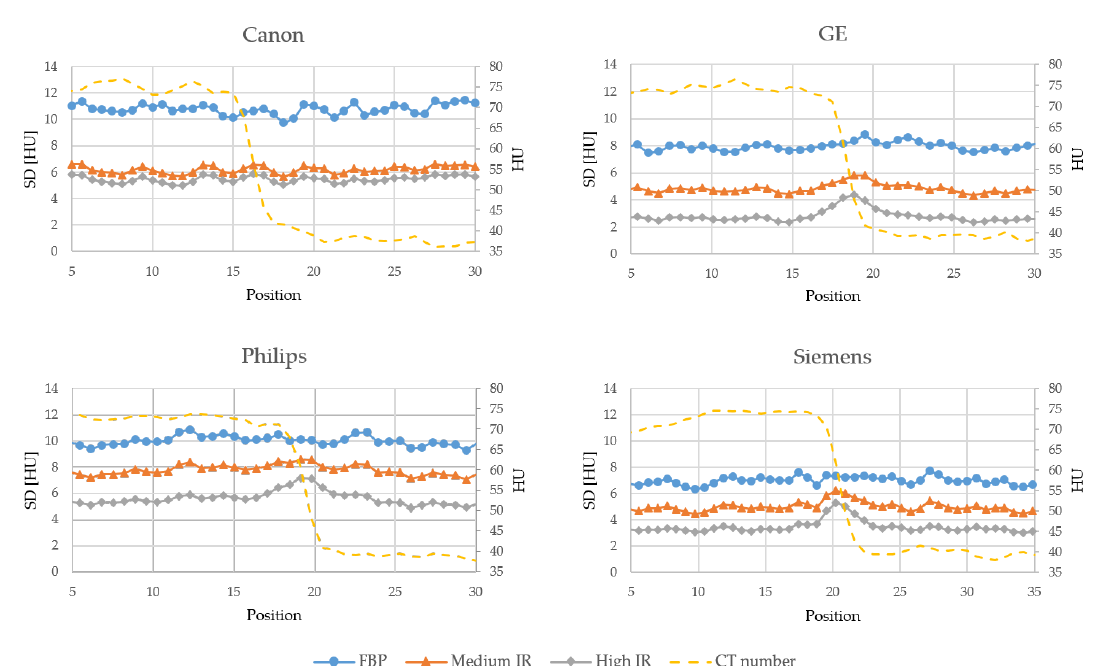
Figure 5. Edge profiles showing the standard deviation (SD) measured over the 30 HU edge in the noise maps reconstructed with FBP, a medium level of IR and a high level of IR for each vendor. The dashed line shows the average CT number in the FBP images. Table 2. Average amount and standard deviation of noise reduced outside and at three anatomical edges for two levels of IR relative to FBP, measured in the calculated noise maps (see Appendix A). The difference in noise reduced outside and at each anatomical edge is listed in percentage points (pp). Noise Reduction Relative to Edge IR Level Position